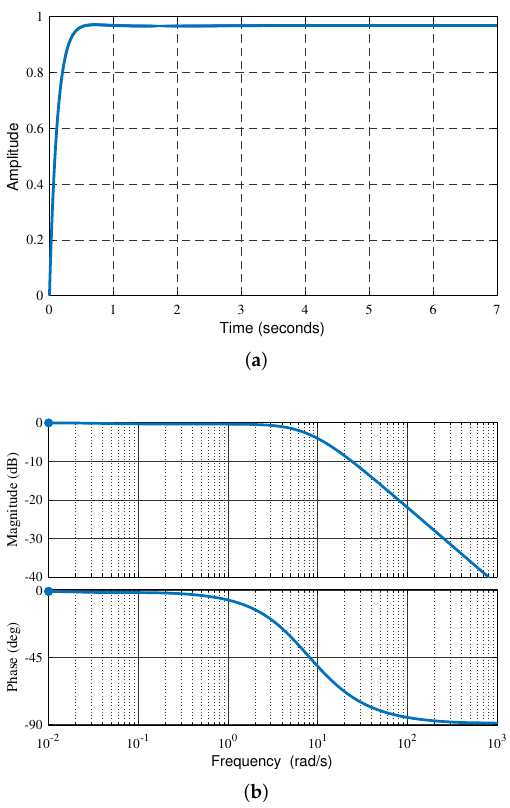
Figure 7. ( a ) Step response and ( b ) bode plot of the proposed control